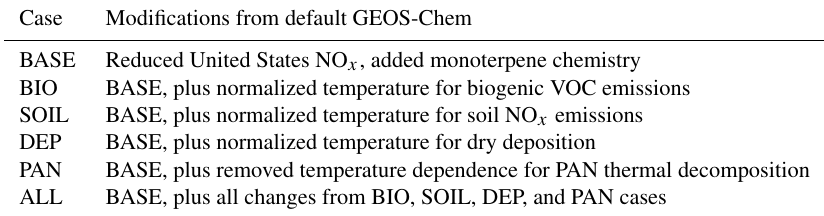
mean-square error of 0.84 and 0.79, mean bias of 0.02